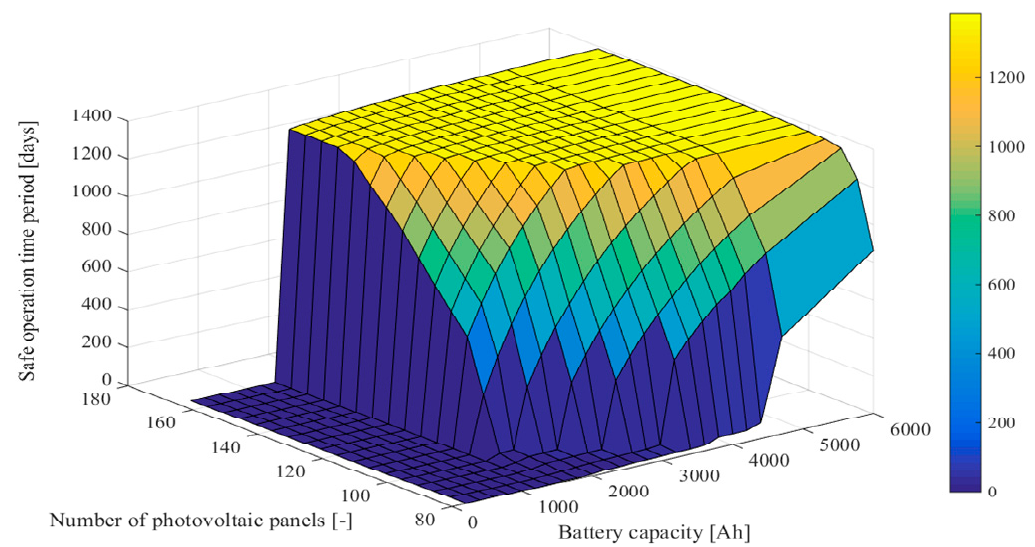
Figure 12. Battery economic lifetime for the SAPV system with respect to the capacity of the 108 V AGM VRLA battery system (200, 400, …, 4200, 4400, 4700, and 6000 Ah) and PV population (80, 85, …, and 165).